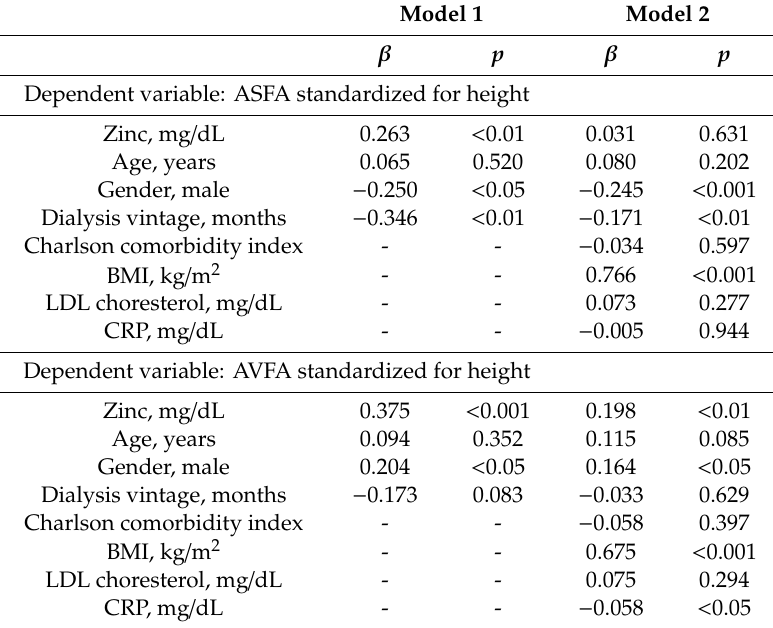
Table 3. Multiple regression analysis with ASFA standardized for height or AVFA standardized for height as the dependent variables and serum Zinc levels, age, gender, dialysis vintage, BMI, LDL cholesterol, and CRP as the independent